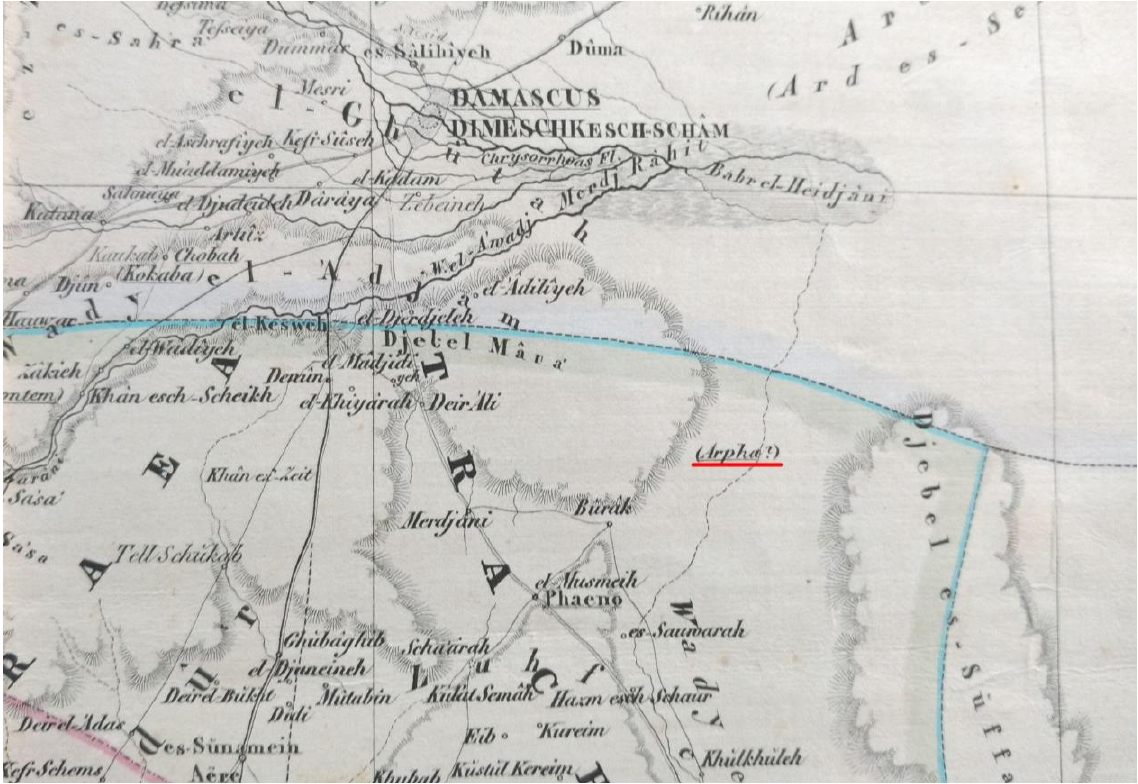
Figure 2: Map detail from H. Kiepert’s map after Robinson´s journey, 1842 (Arpha) - in detail: lower right image